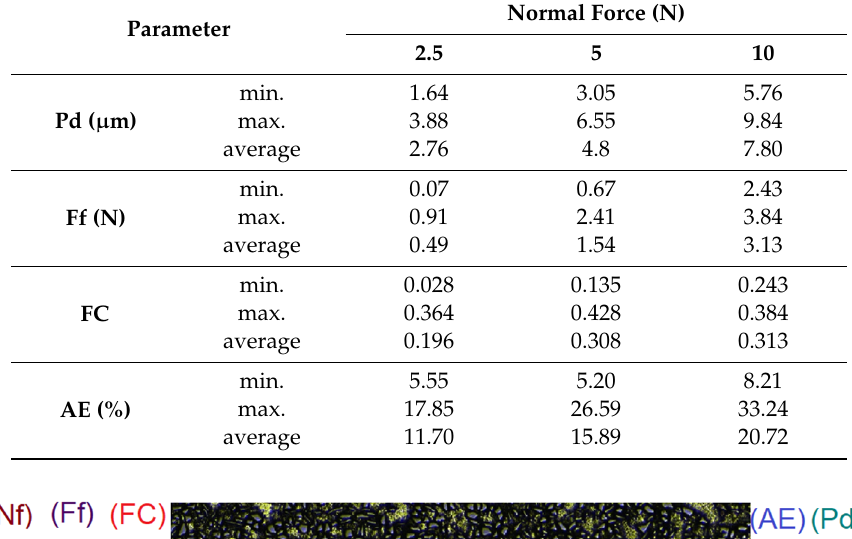
Table 3. Values of penetration depth (Pd), friction force (Ff), friction coe ffi cient (FC), and acoustic emission signal (AE) recorded in the course of scratch tests performed in the AlSi12 / SiC p composite layer area.